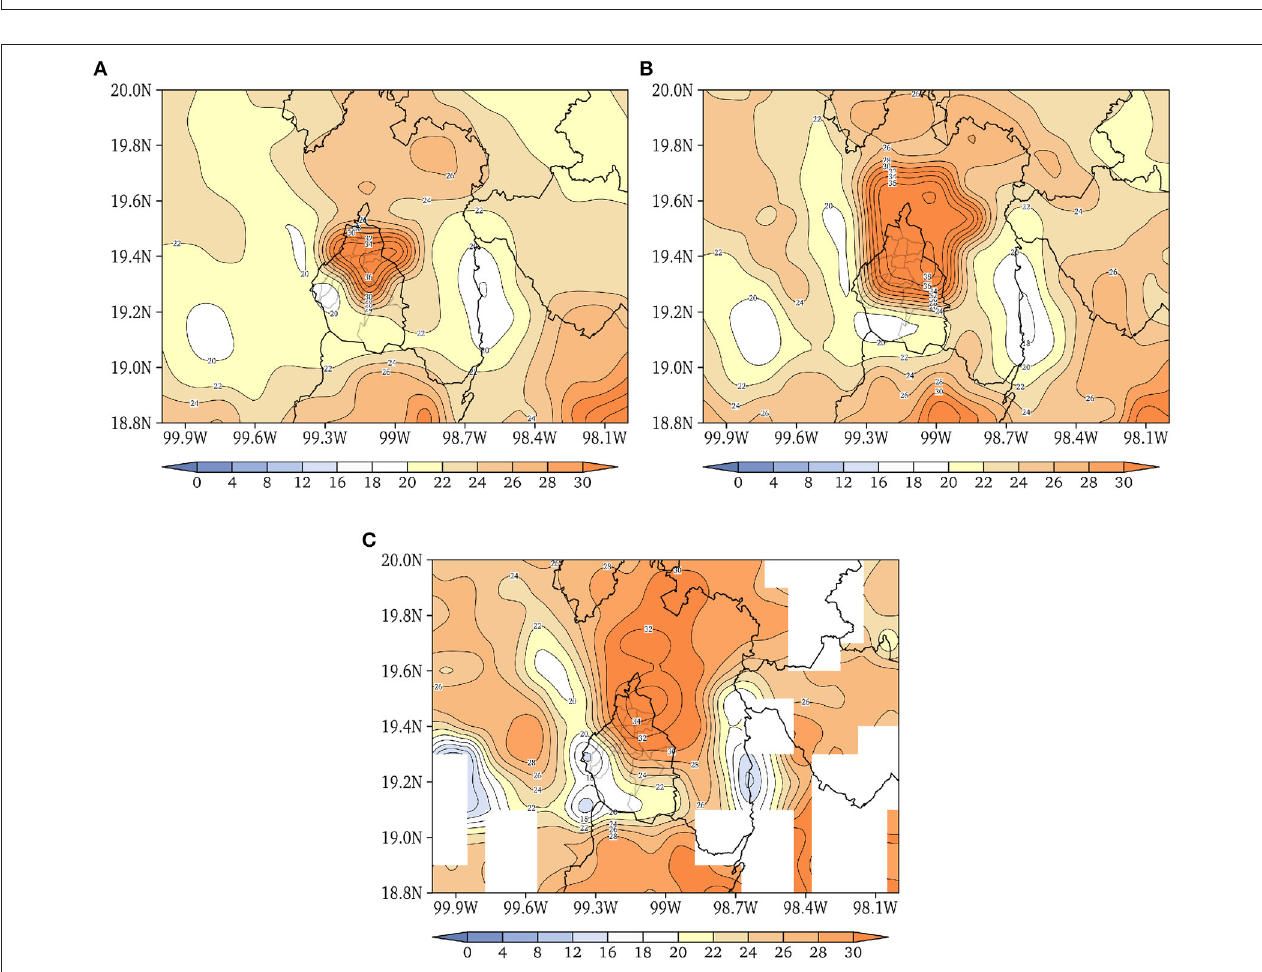
FIGURE 6 | Comparison of skin temperature ( ◦ C) for 21 July 2014 between experiments: (A) Control experiment; (B) Experiment modifying land cover; and (C) MODIS satellite images.